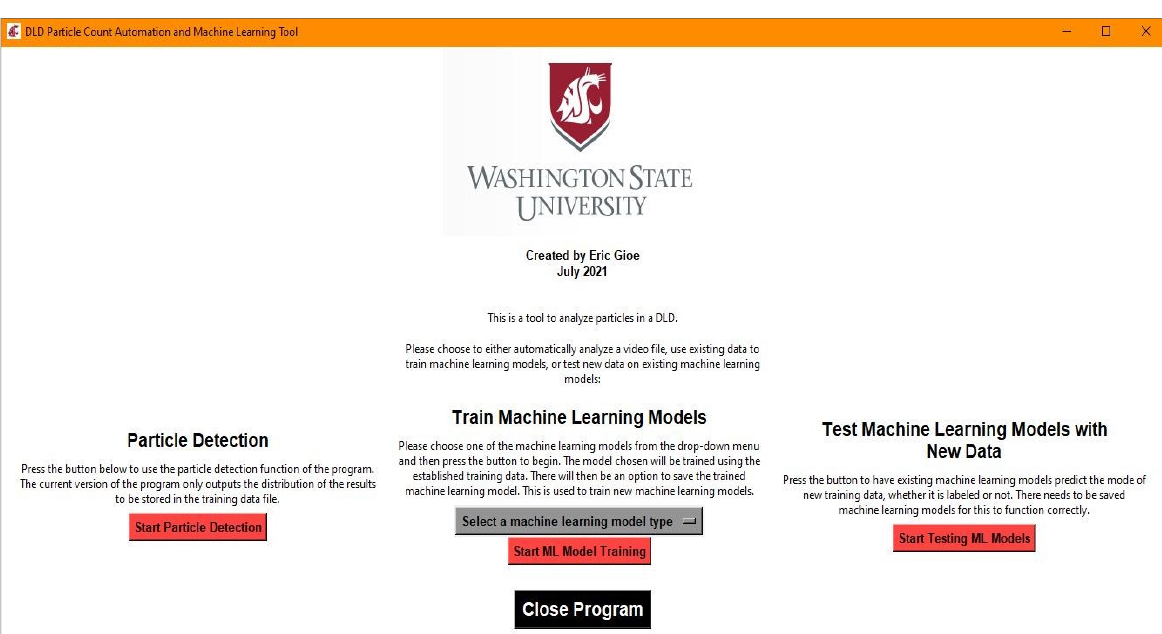
Figure 2. GUI used as the main window, which can launch one of three actions: the particle detection function, the machine learning model training function, and the function to test the existing machine learning models, if any are saved.